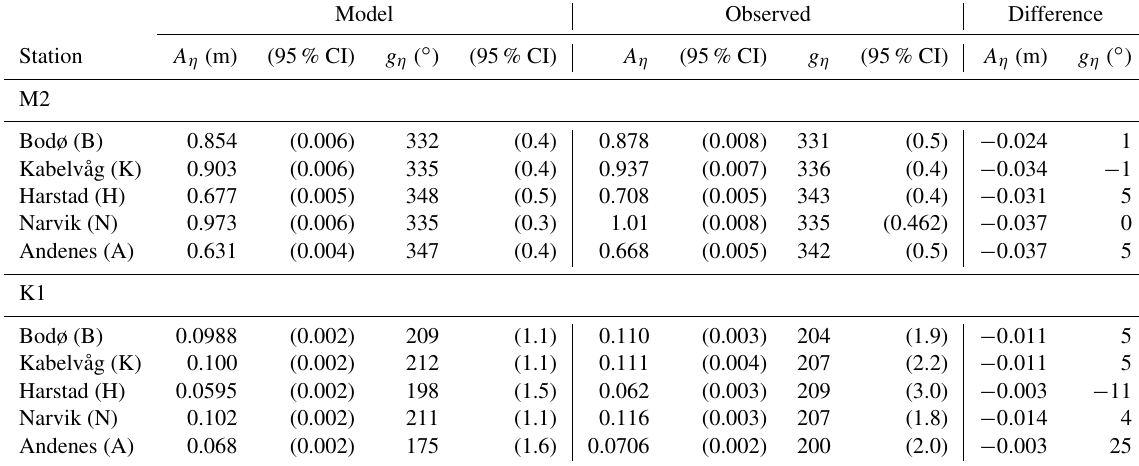
Table 1. Amplitude and phase of modeled and observed sea surface height for M2 and K1 tidal constituents. The difference is given as model minus observation. Observations are collected from the Norwegian Mapping Authority, Hydrographic Service (2021) (also displayed in Fig. 7).